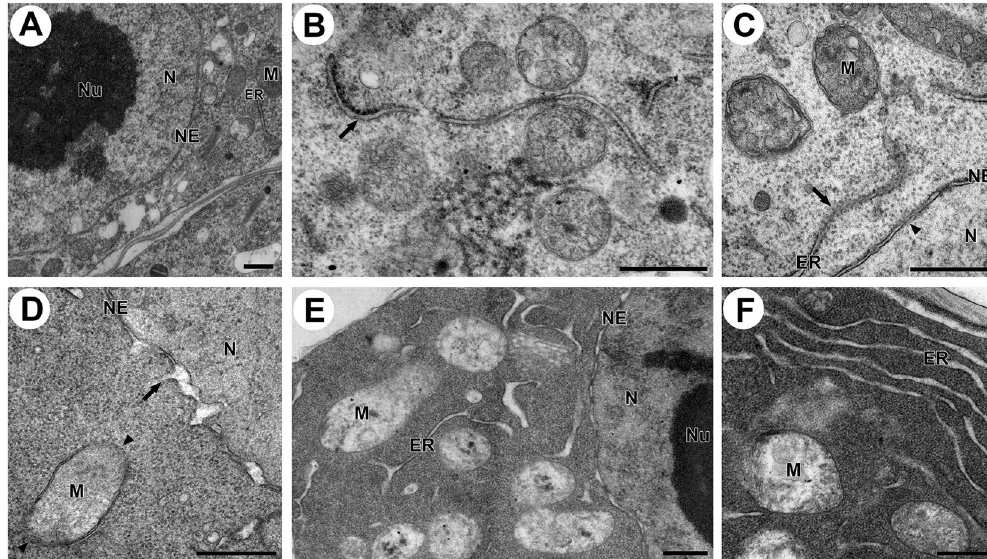
Figure 8. Transmission electron micrographs of tapetal cells. ( A ) Structure and distribution of organelles in a control cell. ( B ) Formation of smooth endoplasmic reticulum (arrow) lacking ribosomes under high temperature conditions. ( C ) Degradation of components of the ER (arrow) and NE (arrow head) by high temperature treatment. ( D ) Swollen and reptured NE lumen (arrow), and degradation of the outer membrane of mitochondria (arrow head) after high temperature treatments. ( E ) Swollen and ruptured NE and ER lumens after high temperature treatment. ( F ) Highly electron dense cytoplasm and swollen ERs after high temperature treatment. N, Nucleus; Nu, Nucleolus; NE, Nuclear envelope; M, Mitochondrion; ER, Endoplasmic reticulum. Bars = 0.5 μ